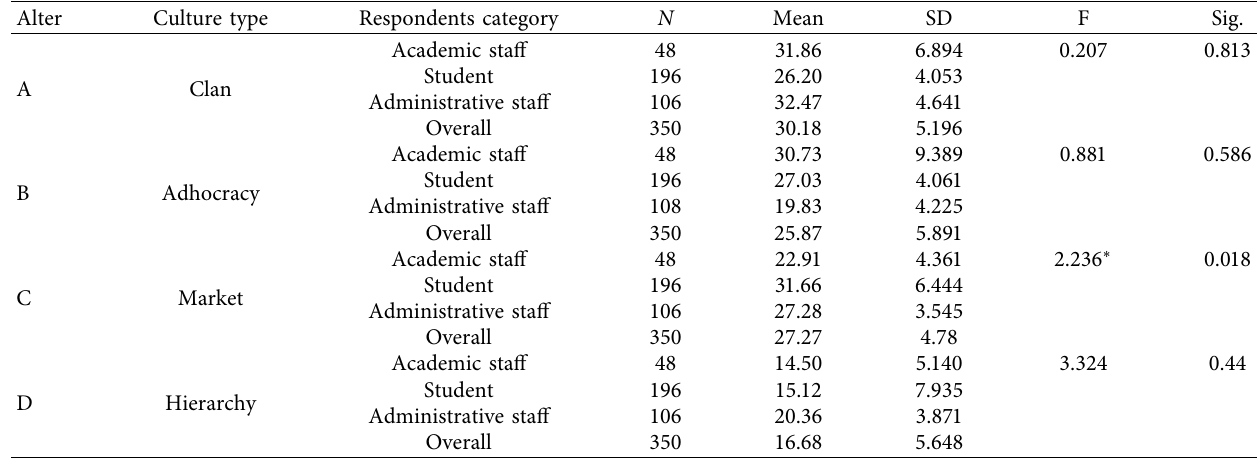
Table 4: In the preferred